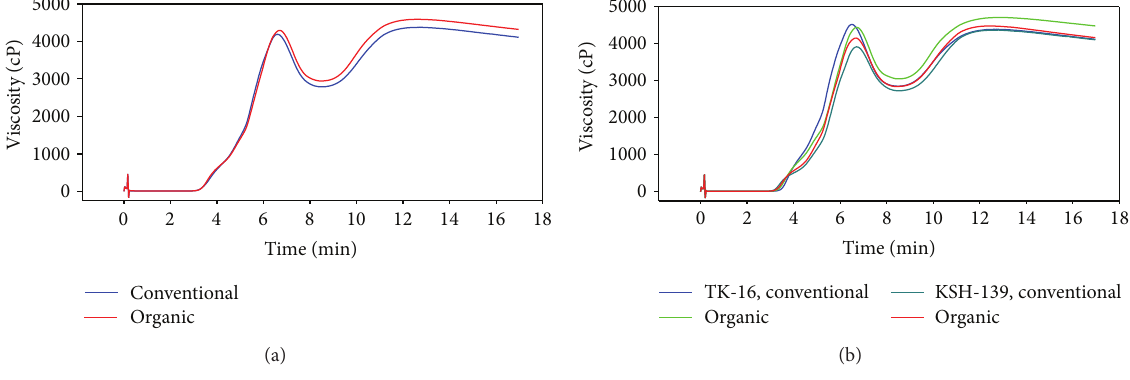
Figure 2: RVA profiles of rice cultivars compared according to (a) farming practices and (b) varietal